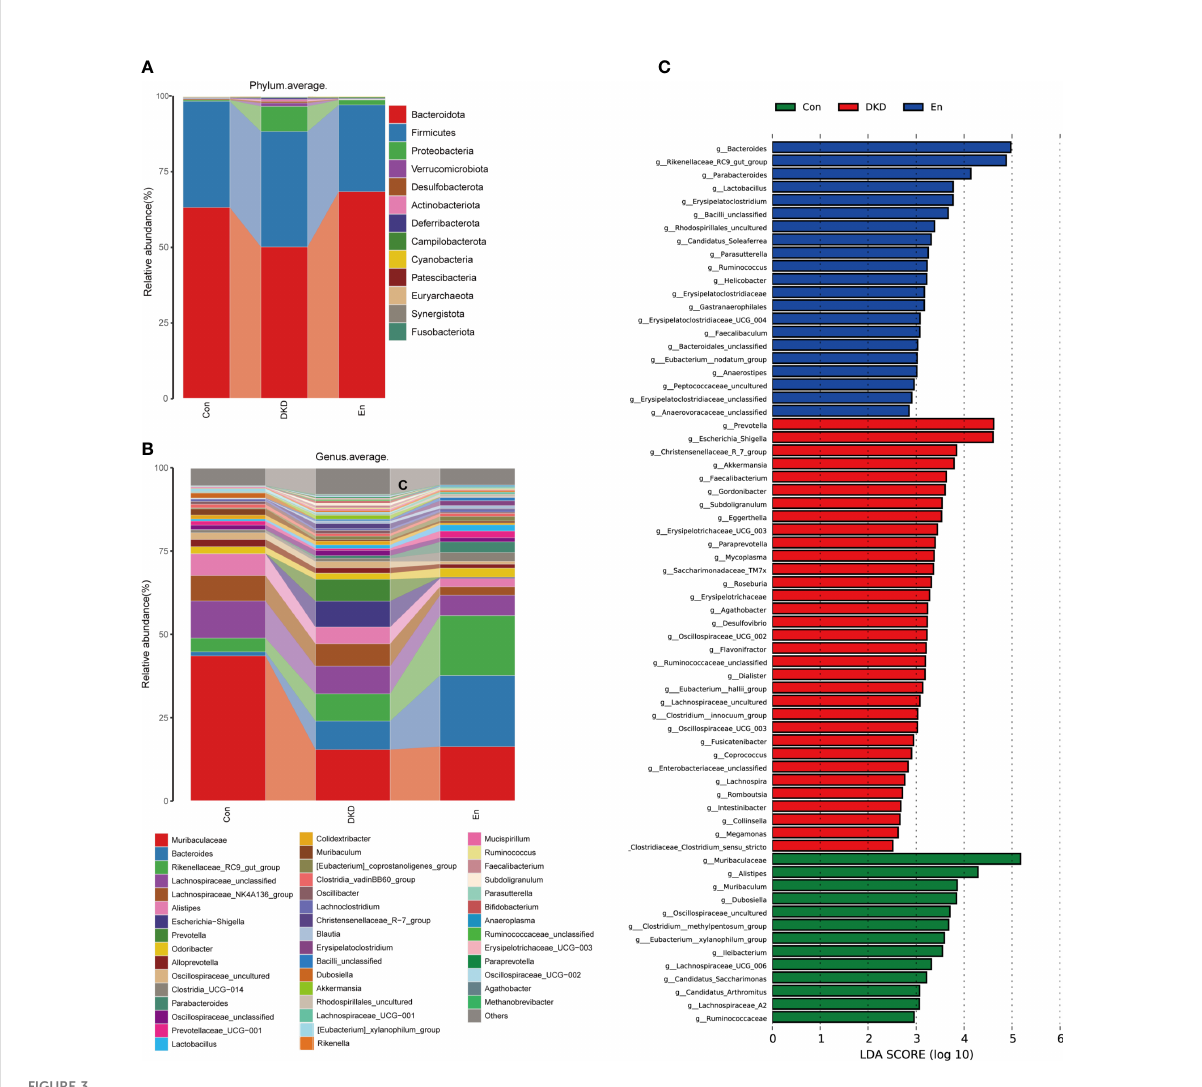
FIGURE 3 Analysis of gut microbiota composition and biomarkers in different groups. (A, B) Bar plots of the composition of intestinal fl ora at the phylum and genus levels. (C) LefSe analysis of microbial pro fi les in each groups at the genus level (LDA ≥